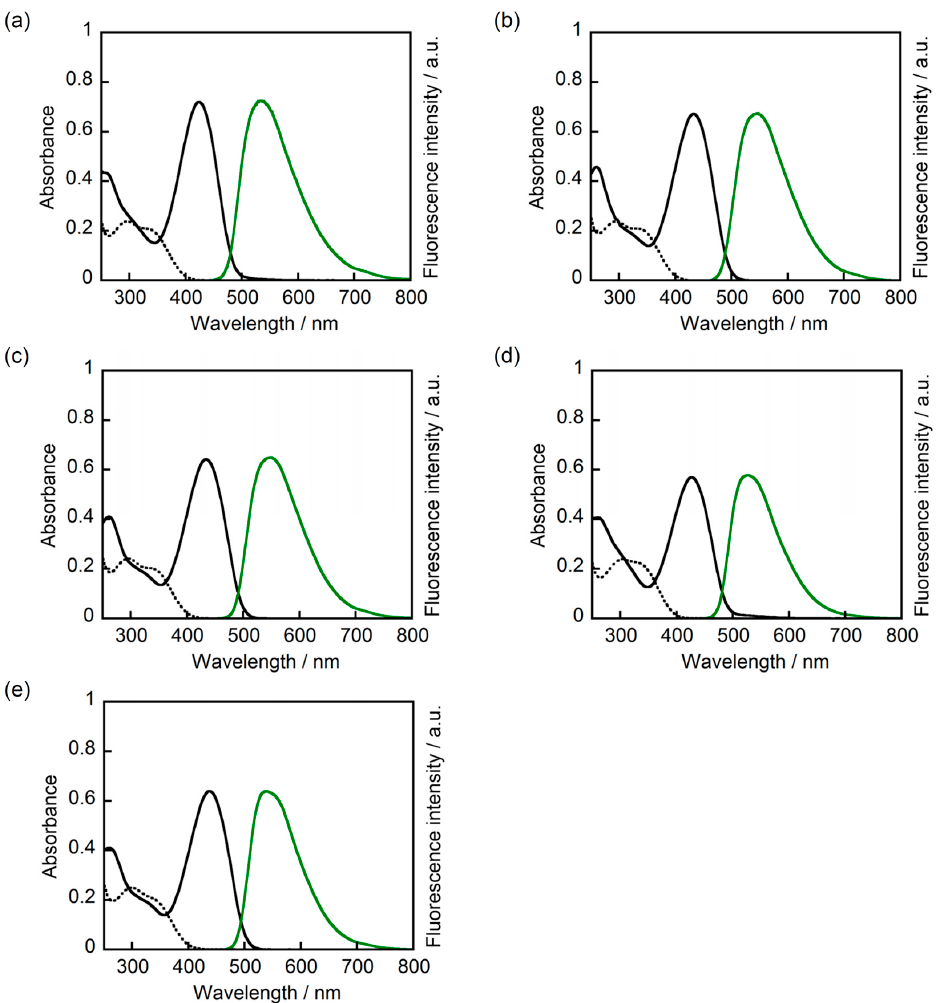
Figure 1. Absorption and fluorescence spectra of 1 ( a ); 2 ( b ); 3 ( c ); 4 ( d ); and 5 ( e ) in 1,4-dioxane (3.0 × 10 − 5 M). Black dashed lines: absorption spectra of open-ring isomers 1a – 5a , black solid lines: absorption spectra of closed-ring isomers 1b – 5b , green solid lines: fluorescence spectra (uncorrected) of closed-ring isomers 1b – 5b .